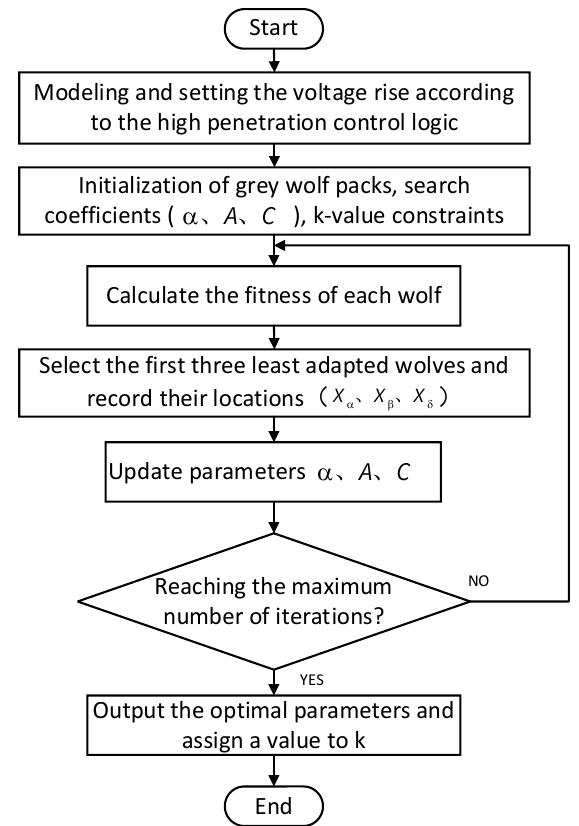
Figure 5. Flow chart of grey wolf algorithm for solving the optimal k value.